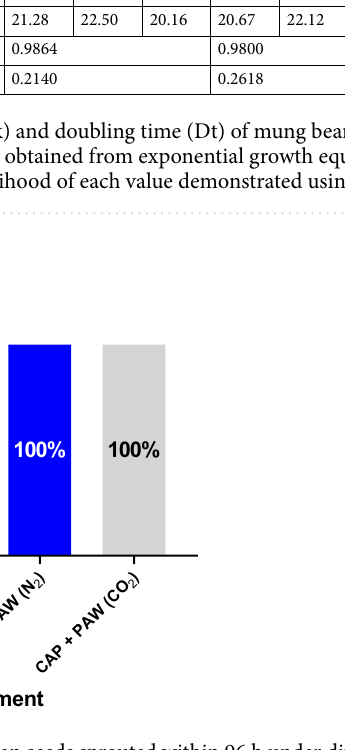
Figure 1. Percentage of mung bean seeds sprouted within 96 h under different combined plasma